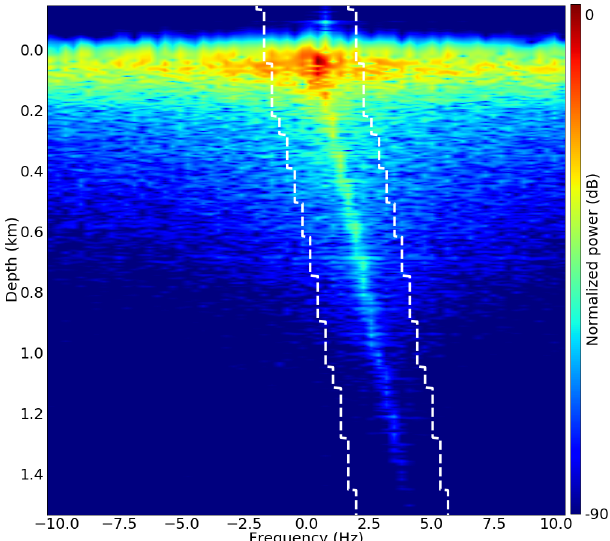
Figure 7. Azimuth spectrum of a 250m long SAR block in track 1, azimuth position x = 59km. The frequency interval ˆ f layer (d) ± 0 . 05 B az is marked with white lines.